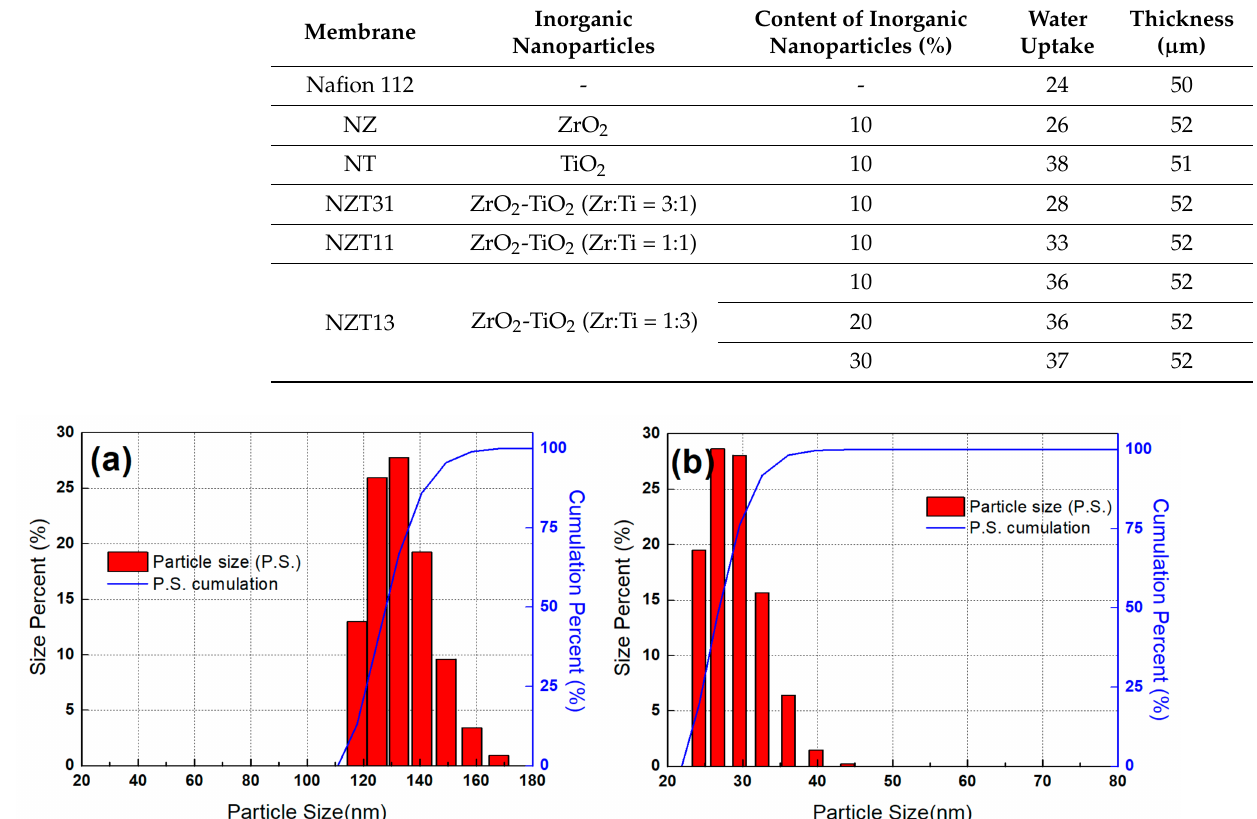
Table 1. Type of membrane used in this experiment.